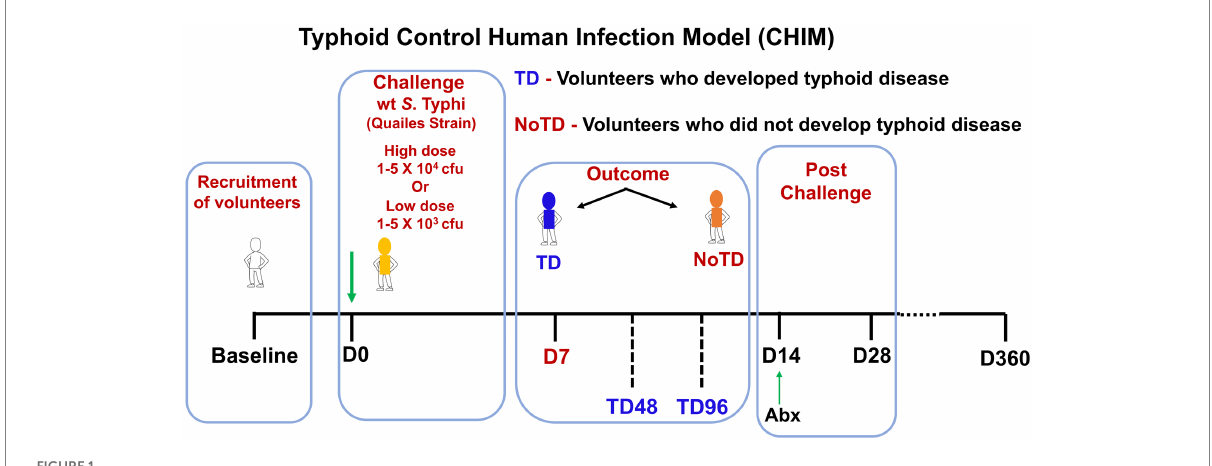
FIGURE 1 Schematic of a typhoid control human infection model (CHIM). Volunteers were recruited and challenged on day 0 with wt S . Typhi (Quailes Strain) at either of two doses (low—10 3 CFU or high—10 4 CFU). At around day 7, some of volunteers developed typhoid disease (TD) while others did not develop typhoid disease (NoTD). On day 14, all volunteers (TD and NoTD) received antibiotics (Abx). PBMC were collected from multiple time points from baseline up to 360 days after